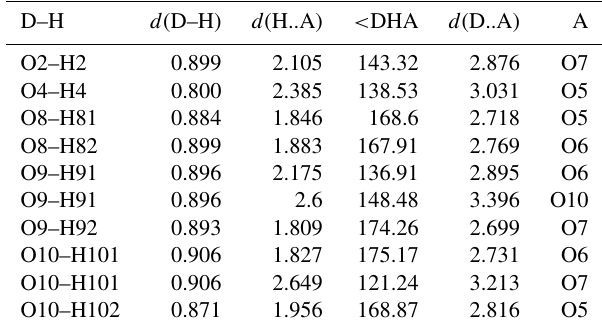
Table 5. Hydrogen bonding in gobelinite from Cap Garonne.